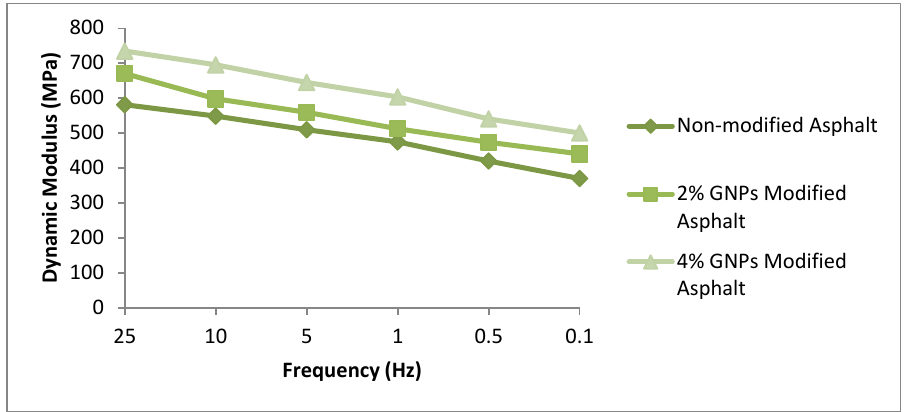
Figure 11. The Dynamic Modulus at 55 °C. GNPs = Graphene Nano-Platelets.